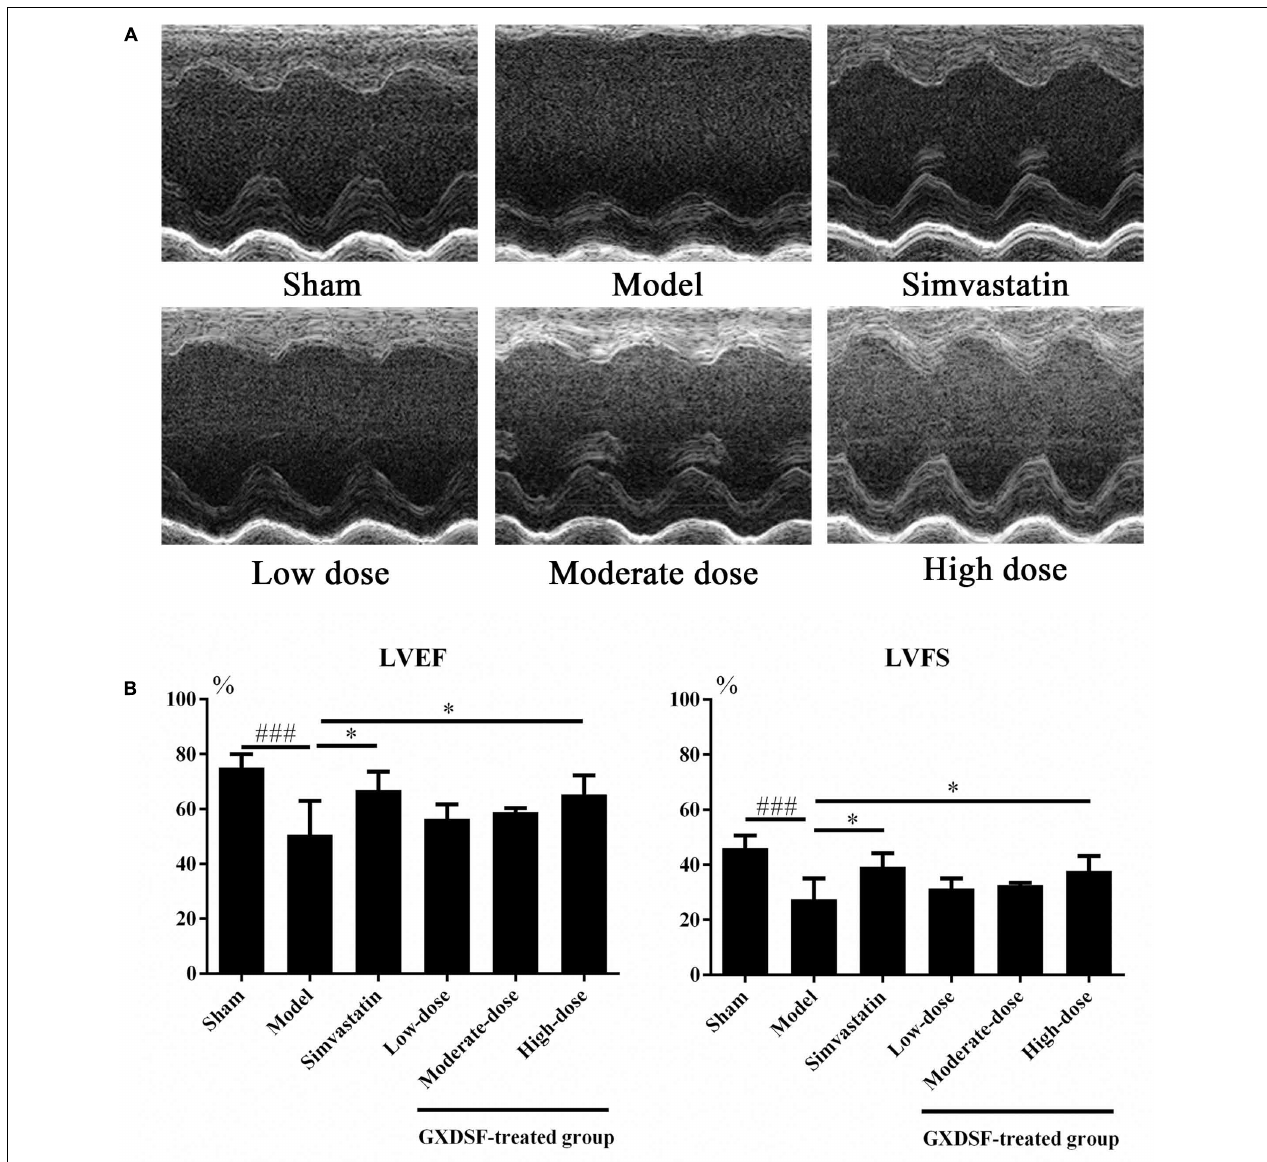
FIGURE 3 | Echocardiogram parameters in MIRI-LVR rats treated with different doses of GXDSF. The echocardiograms (A) were obtained using the Vevo 770 high-resolution imaging system. LVEF and LVFS (B) data are also shown in bar graphs. Compared with the sham group: ### P < 0.001. Compared with the MIRI-LVR model group: ∗ P < 0.05. The data are presented as the mean ± SD ( n = 10 in each group).